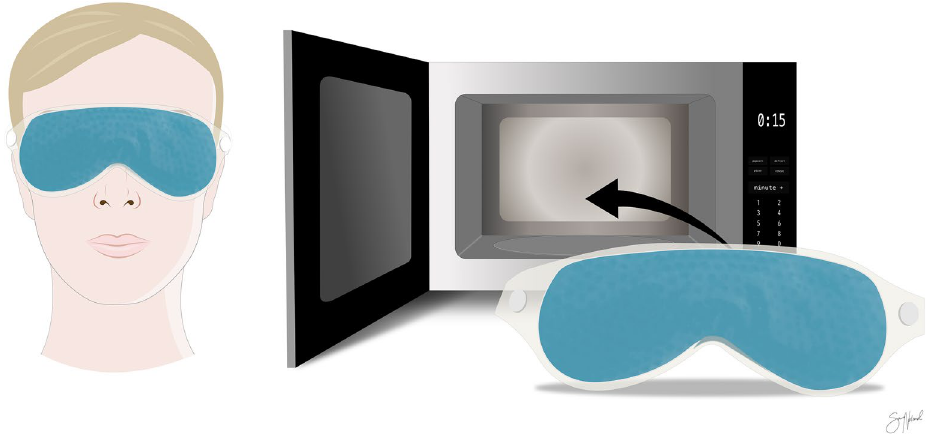
Figure 2. TheraPearl eye mask (Bausch & Lomb Inc., New York, USA) is preheated in a microwave before being placed on the eyelids for about 10–15 min. Figure created in Affinity Designer version 1.8 (Serif (Europe) Ltd., Nottingham, UK).